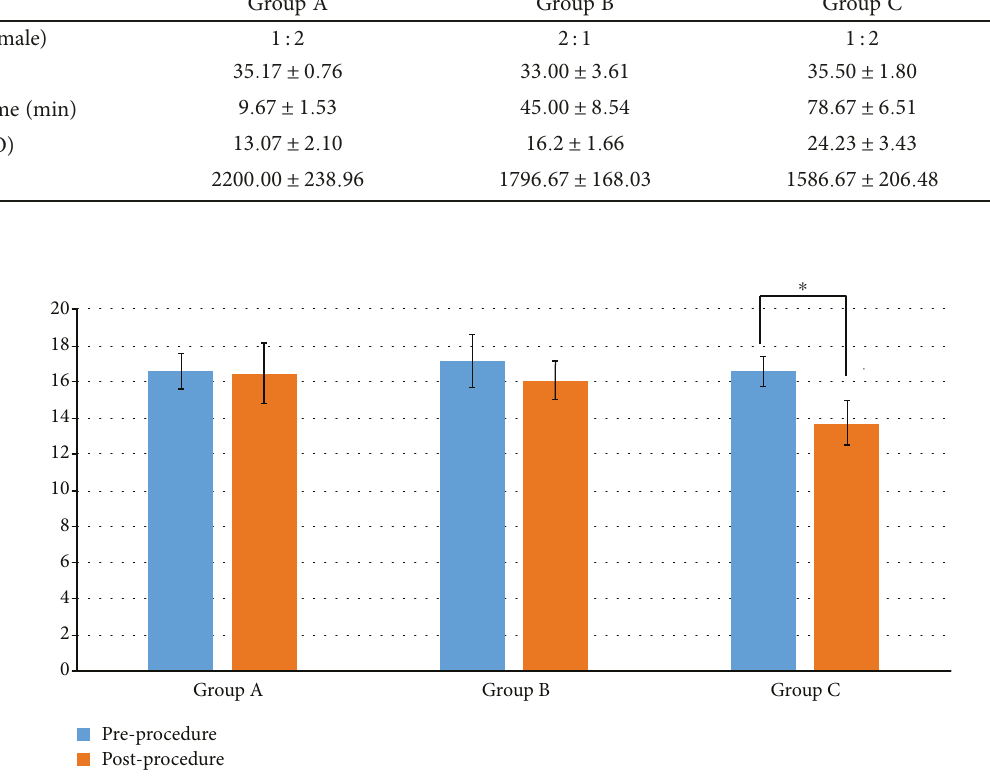
Figure 3: The result of the width cardia pre- and postprocedure.